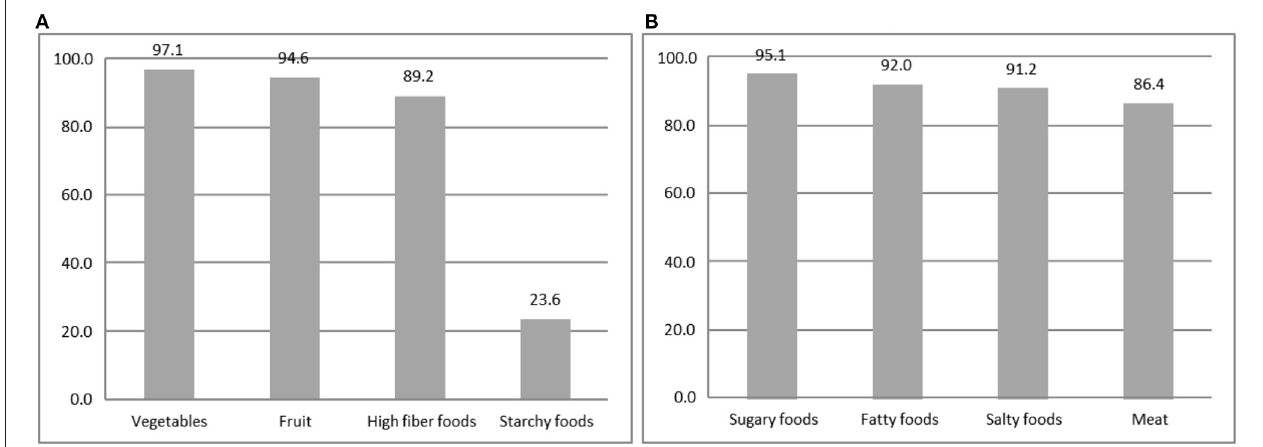
FIGURE 1 | Recommendation of NK1 Expert—percentage of the correct answers of selected items. (A) Food to increase. (B) Food to